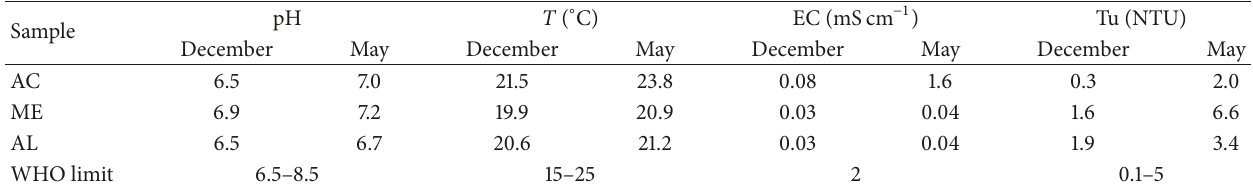
Table 2: Results of physical